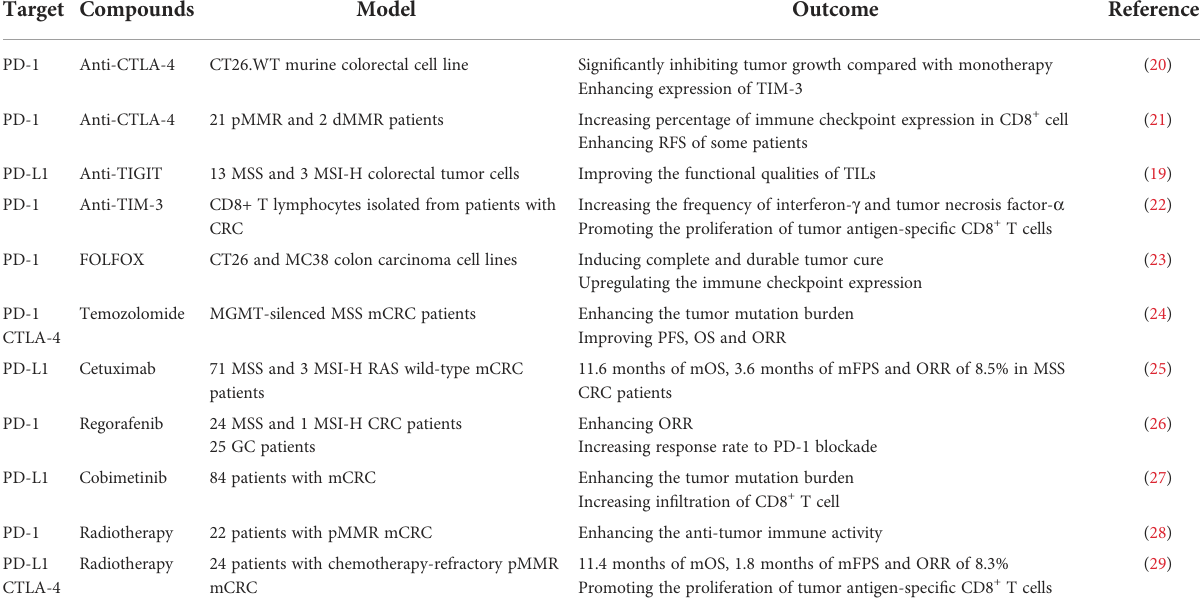
TABLE 1 Protocols to improve the ef fi cacy of immune checkpoint blockade in cold colorectal cancer. Target